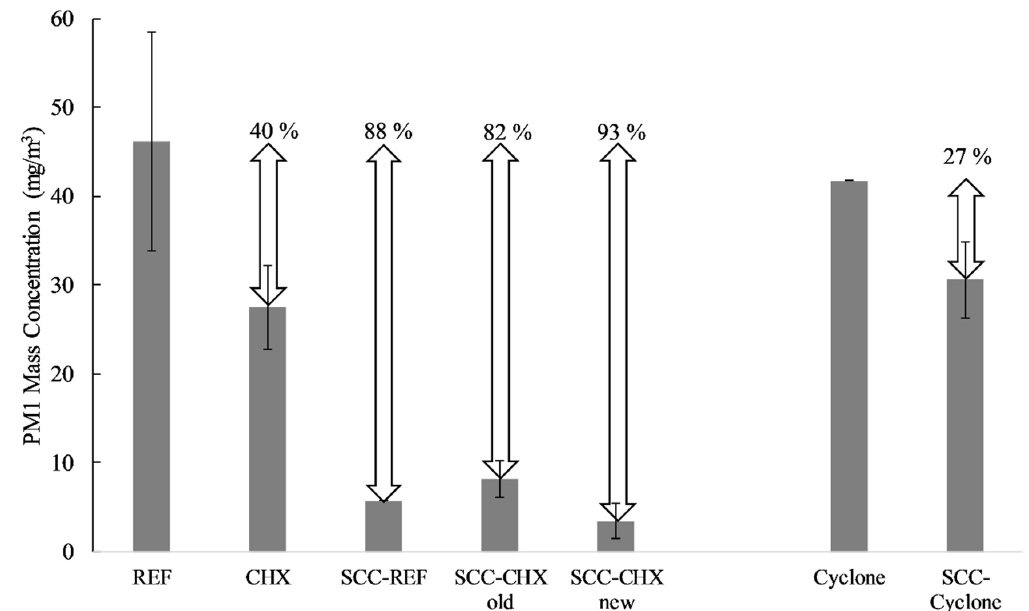
Figure 9. Reduction efficiencies of fine particle (PM1) mass of different setups, at shielded corona charger (SCC) operating temperatures of 400–500 °C, in comparison to the reference boiler (REF) and condensing heat exchanger (CHX). Note that the results originate from different sets of experiments, and therefore the original particle concentration before the deposition systems is likely to be different.